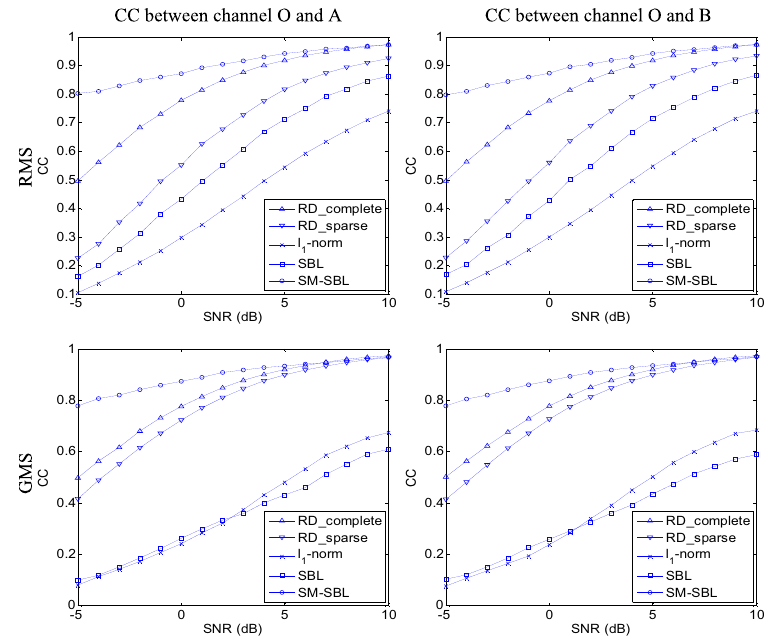
Figure 7. Comparison of correlation coefficients (CC) of multi-channel inverse synthetic aperture radar (ISAR) images under different signal-to-noise ratio (SNR) conditions.